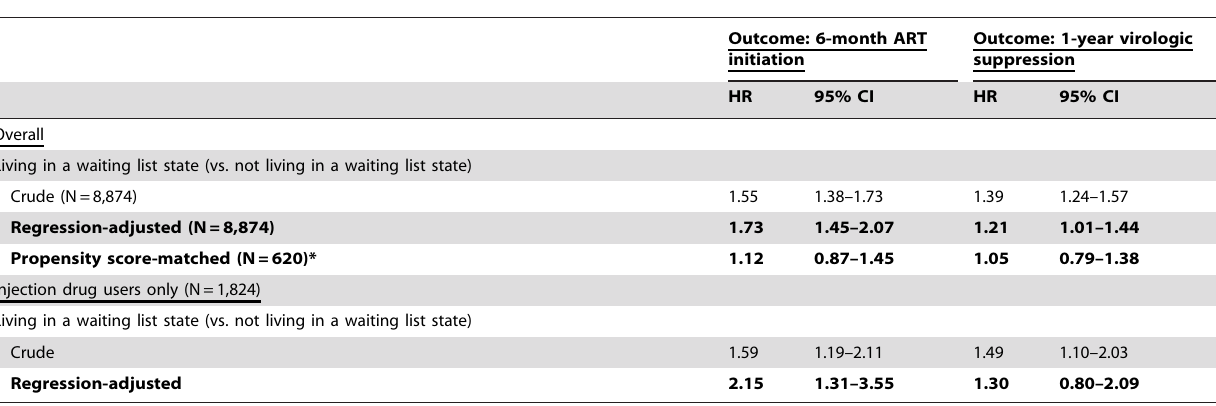
Table 4. Association between living in an ADAP waiting list state and ART initiation and virologic suppression, U.S. NA-ACCORD,